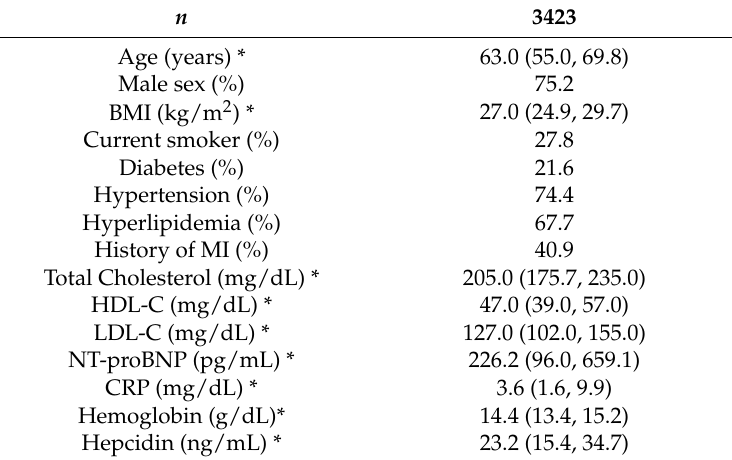
Table 1. Baseline characteristics of the study patients.